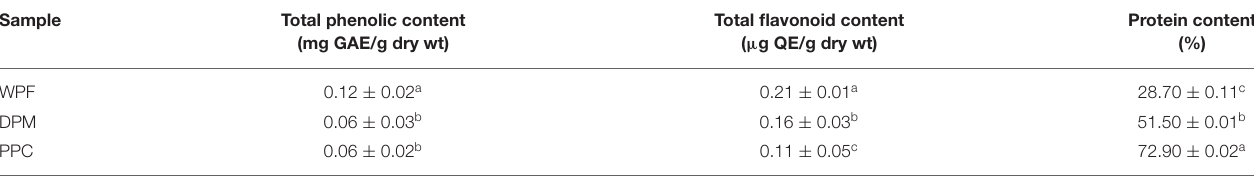
TABLE 1 | Phenolic, flavonoid, and protein contents of whole peanut protein flour, defatted peanut protein meal, and peanut protein concentrate*. Sample